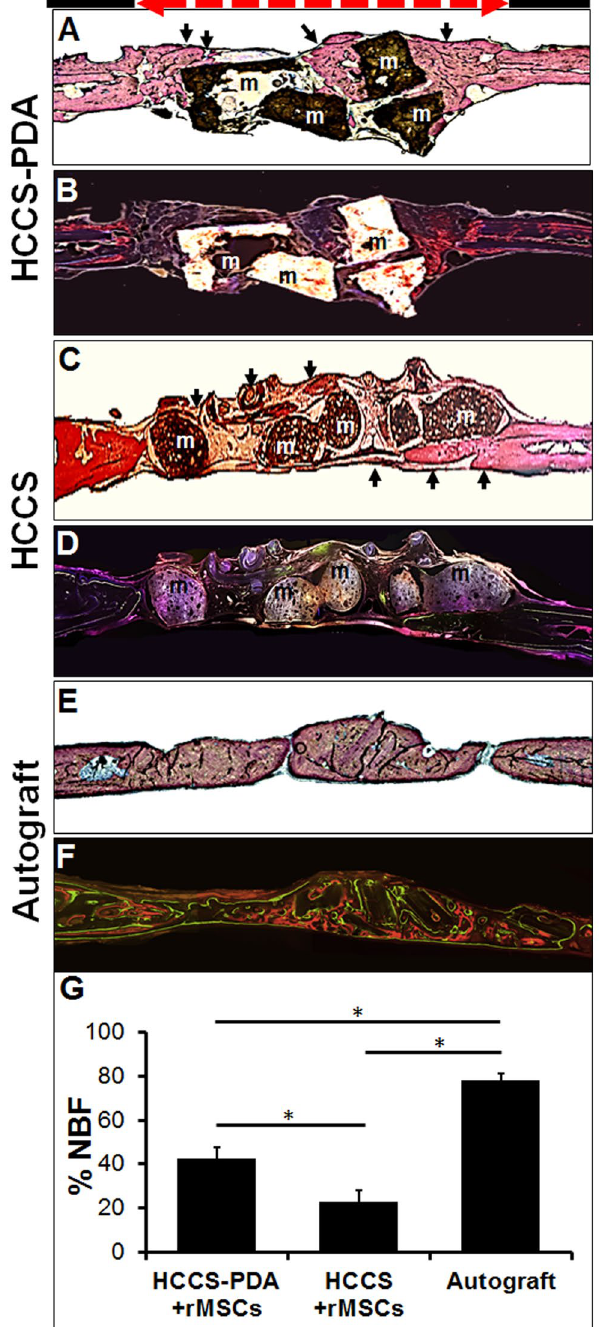
Figure 8. Histological and fluorescent medial-sagittal sections of the defect area after 12 weeks of implantation with HCCS-PDA with rMSC aggregates ( A and B ), HCCS with rMSC aggregates ( C and D ), and autograft ( E and F ). Stevenel Blue and Van Gieson staining revealed new bone formation (NBF), represented by light reddish color (arrows). The area was quantified as a percentage using Image J software, * p < 0.05 ( G ). Fluorescence images labeled with calcein and tetracycline dye were acquired before performing Stevenel Blue and Van Gieson staining. The defect site (red dotted line) is 8